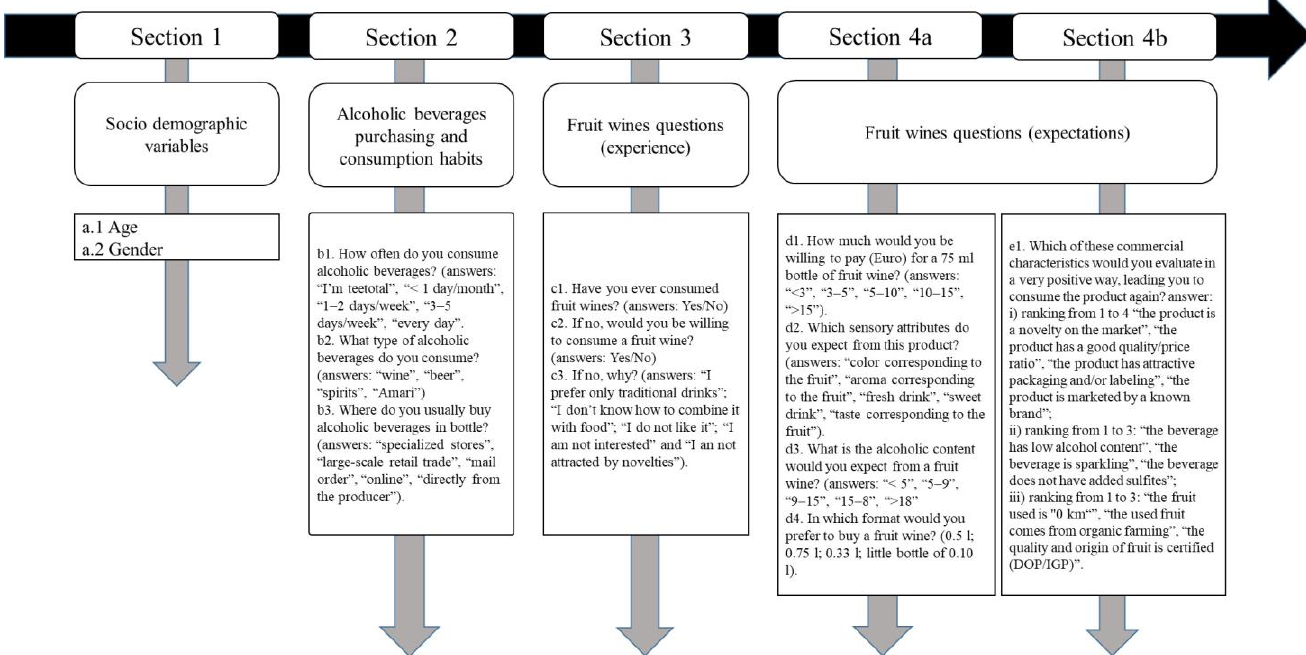
Figure 1. Questionnaire theoretical framework. The arrows indicate the logical path the respondents had to follow during the questionnaire filling process.